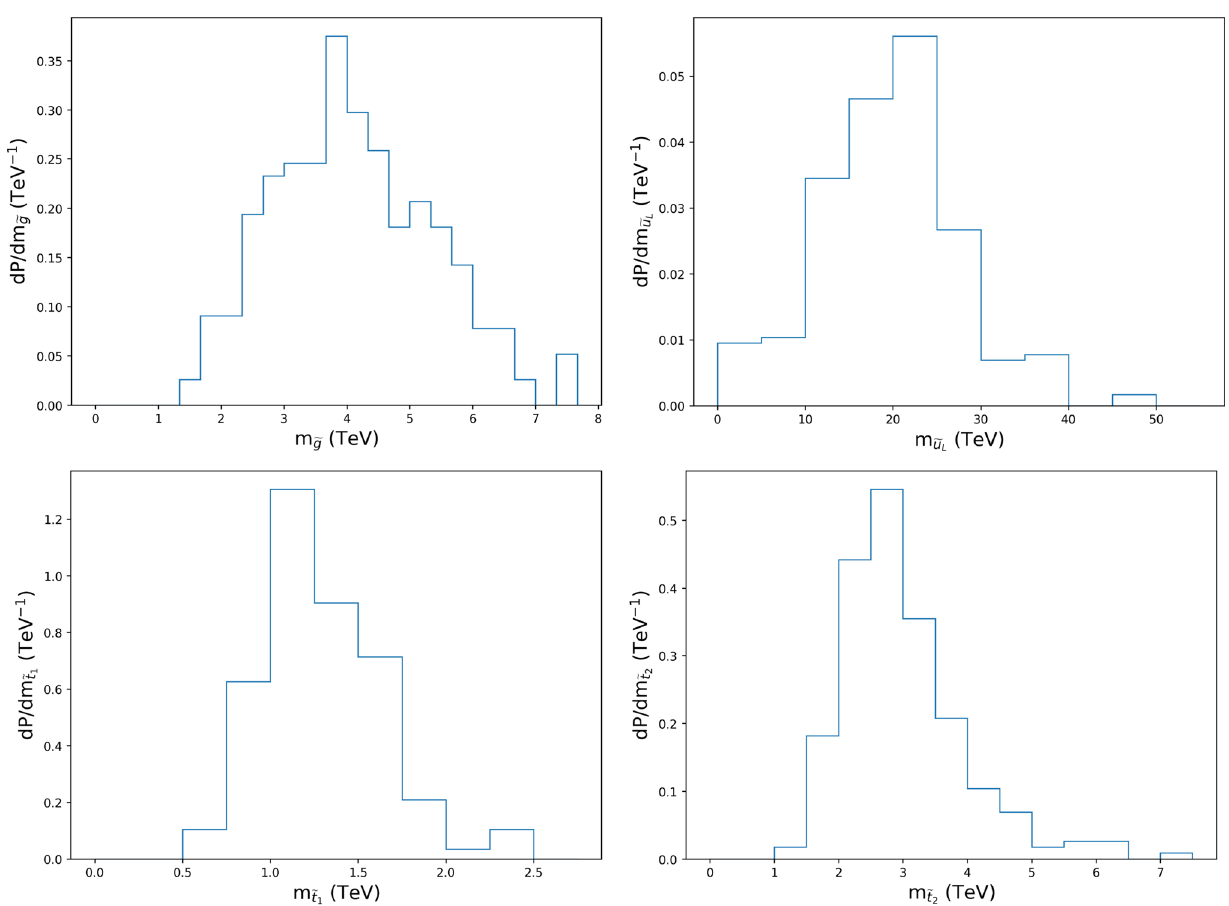
Fig. 7 Distribution of strongly interacting sector masses from a subset of landscape vacua with NUHM3 model as low energy EFT and an n = 1 statistical draw. We show distributions in a m ˜ g , b m ˜ u higher than Isasugra. In frame (b), we see the distribution in m A which runs from 1–9 TeV with a peak around 4